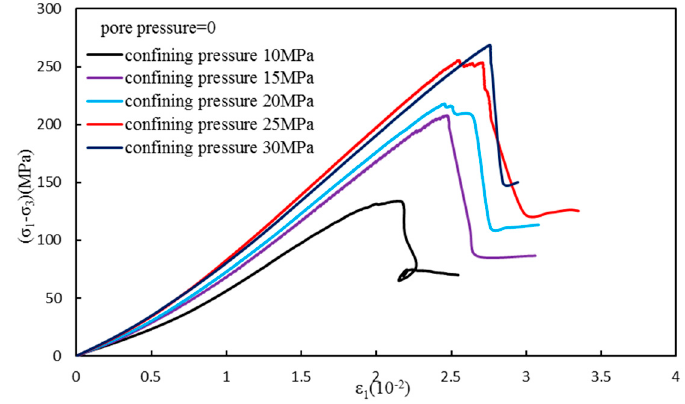
Figure 5. Stress-strain curves from triaxial compression tests under zero gas pressure condition.